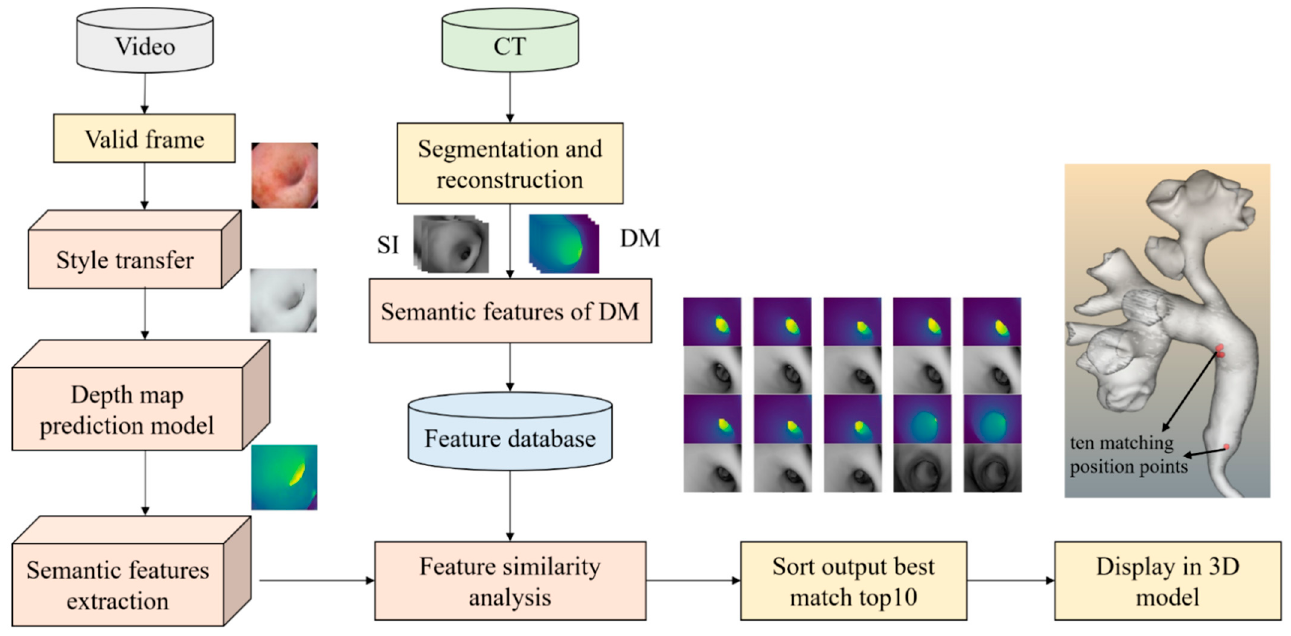
Figure 5. The process of semantic feature matching.